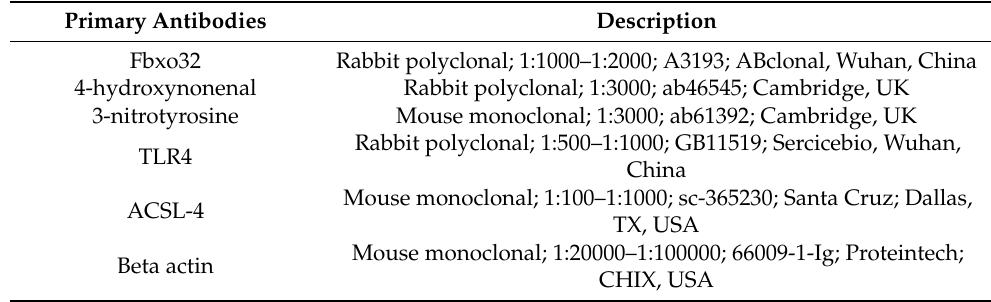
Table 2. Primary antibodies used for Western blot